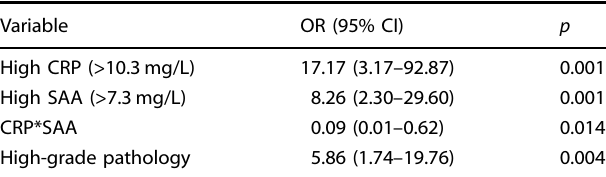
Table 6. Final multivariable conditional logistic regression model (HER2 −